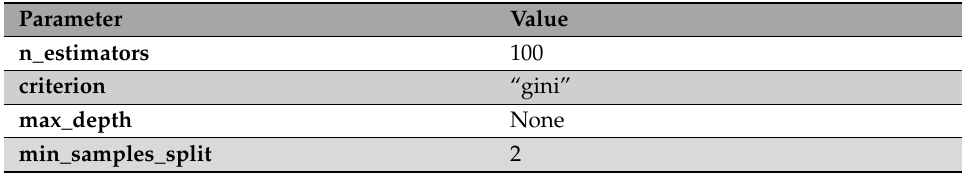
Table 2. Summary of the used Random Forest